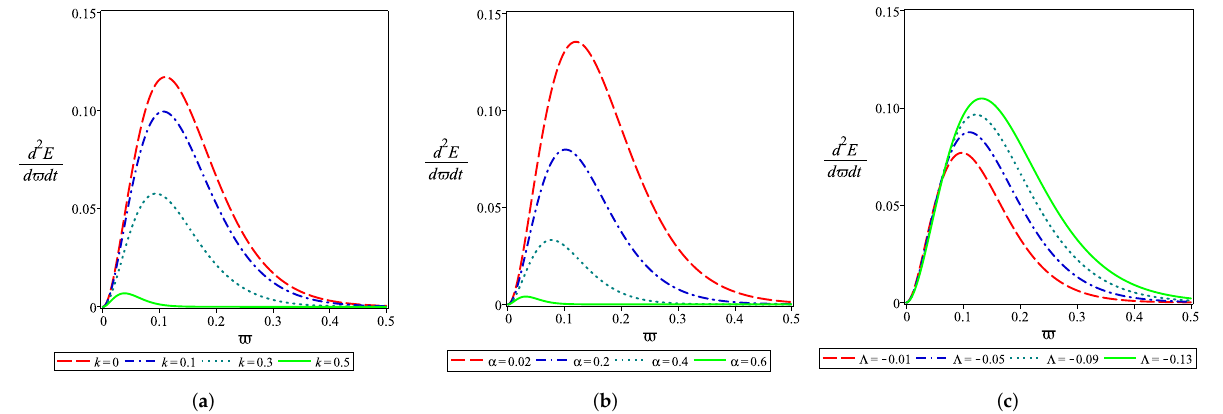
Figure 2. Energy emission rate of the black hole for M = 1 and different values of k , α and Λ . It is transparent from the plots that the energy emission decreases with increasing values of these three parameters, and that the radiation rate is highly affected by the GB coupling constant, whereas the variation of Λ has a weaker effect on the radiation rate compared to other two parameters. See the text for more details. ( a ) α = 0.2 and Λ = − 0.02; ( b ) k = 0.2 and Λ = − 0.02; ( c ) k = α =